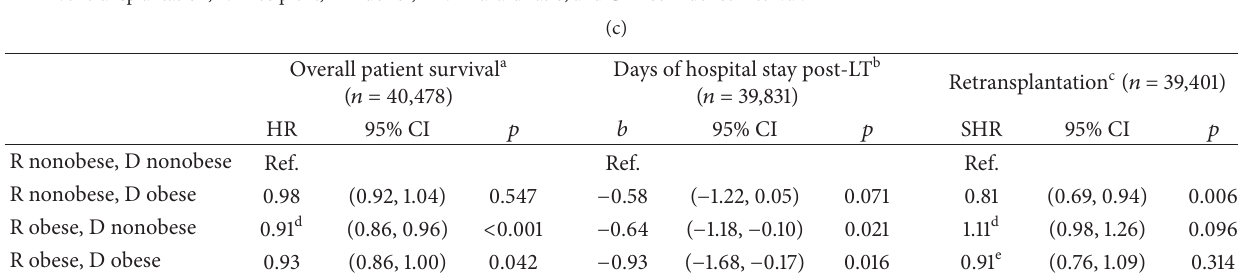
and R race, D and R age, R diagnosis, D and R diabetes history, D and R serum creatinine, D and R bilirubin, R INR, albumin, and MELD score at LT, and D SGOT and SGPT, acute rejection, PVT, and cold ischemia time. LT = liver transplantation, R = recipient, D = donor, HR = hazard ratio, and CI = confidence